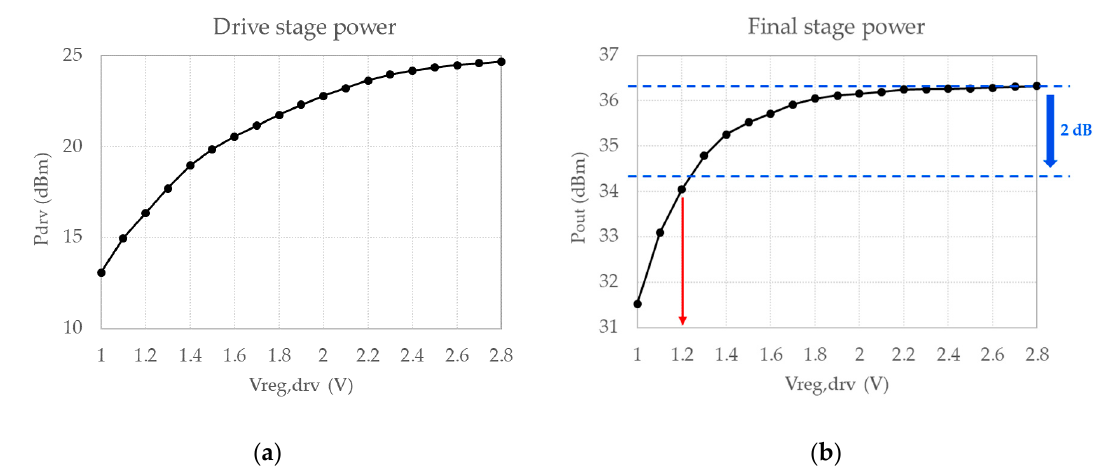
Figure 7. Simulation result of: ( a ) drive stage power over the drive base bias voltage (V reg, drv ); ( b ) final stage power over V reg,drv .